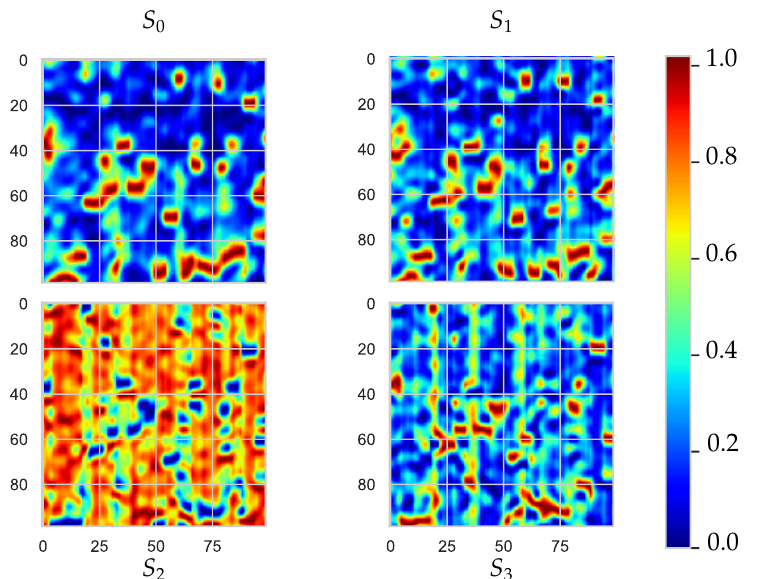
Figure 3. Polyethylene (PE)-coated sample polarization measurement: S 0 , S 1 , S 2 and S 3 are the Stokes vector as captured by full-Stokes imaging